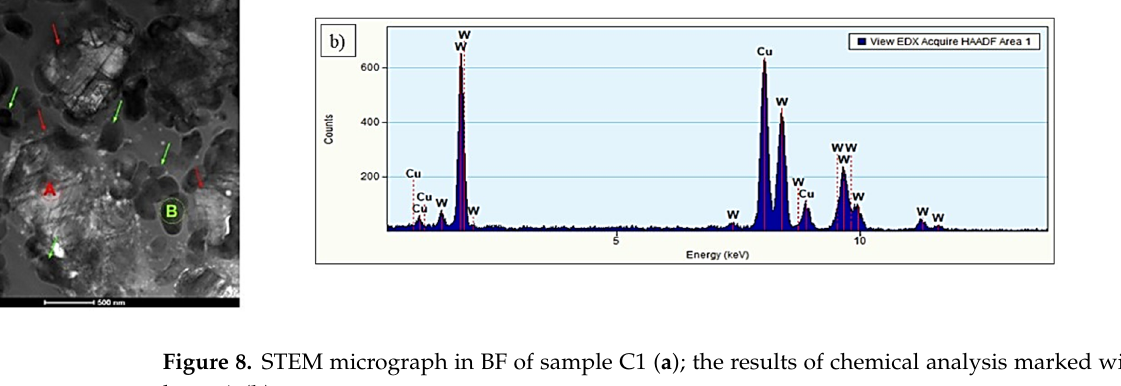
Figure 9. SAED diffraction analysis of sample C1; for the area marked on Figure 8a with letter A: WC [111] ( a ); with letter B: W 2 C [011] ( b ); with letter C as the matrix ( c ). The second type of precipitation, marked with green arrows, has a more regular and spherical shape. It is occurring in the matrix or around the WC shown earlier. Diffraction investigation showed the W 2 C phase (Figure 9b), where Co and Cr replace some W atoms by the structure. The W 2 C phase belongs to the hexagonal system, space group P-3m1 [33]. Process parameters significantly influence the microstructure of the coating. Especially important is the point when high temperature affects particles of feedstock material. The 2000–3000 K W 2 C phase is more stable than the WC one in the temperature range. Moreover, the higher temperature of the particles causes decarburization of the WC phase and leads to W 2 C precipitation, which is a harder and more brittle phase. Myalska et al., in their work, provided a detailed explanation of this phenomenon [34]. It was con- firmed by SAED electron diffraction that the matrix is amorphous (Figure 9c). In the C2 sample, the precipitates marked with the letter B (Figure 10a) occur around larger WC carbides. They are irregular in shape and composed of many smaller grains. EDS analysis (Figure 10b) showed a high proportion of W (72 at. %) and Co (28 at. %). The SAED electron diffraction, performed for the area marked as B, confirmed the polycrys- talline structure of the precipitation (Figure 11a). SAED diffraction identified the cubic